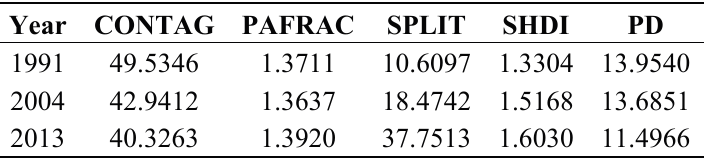
Table 4. Landscape metrics in the study region over time (CONTAG: contagion; PAFRAC: perimeter-area fractal dimension; SPLIT: splitting index; SHDI: Shannon’s diversity index; PD: patch density).